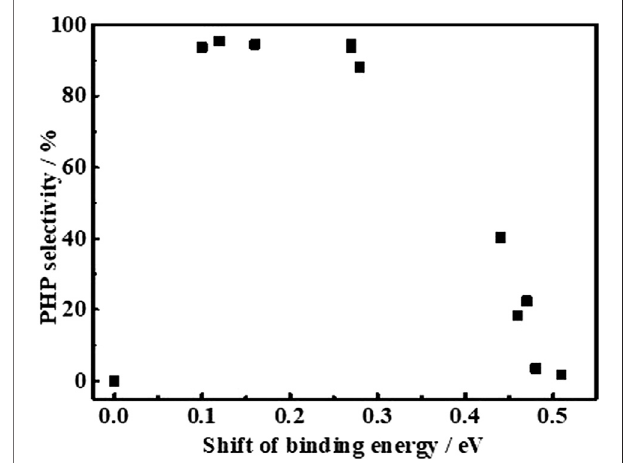
FIGURE 8 | Relationship between shifts of Ni ° 2P 3/2 binding energy in XPS with the PHP